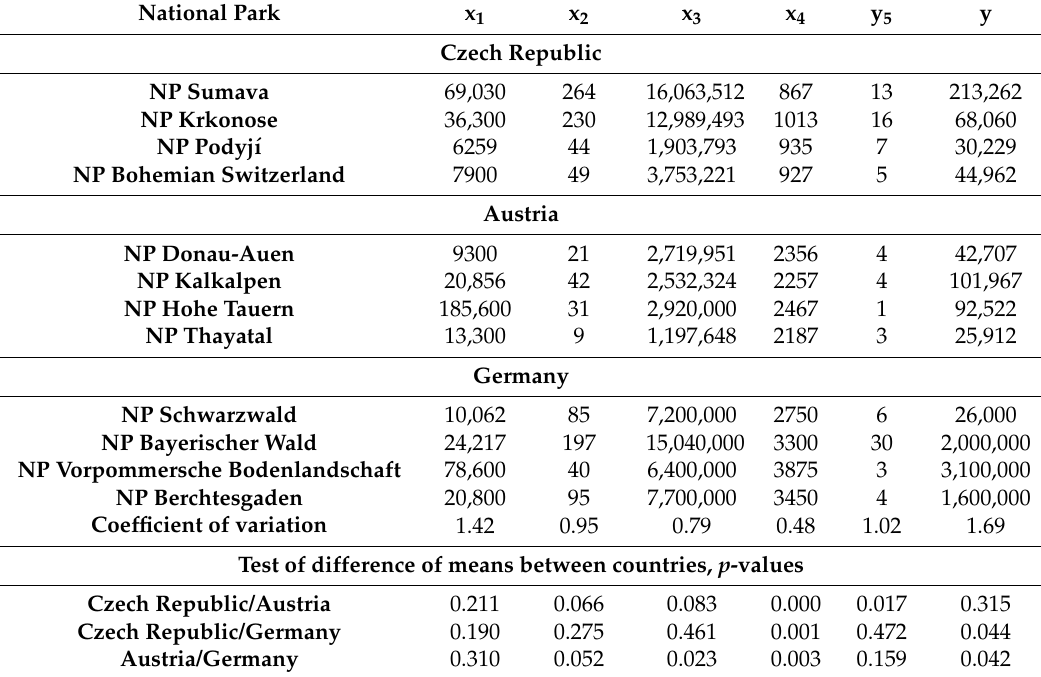
Table 1. Collected data of national parks in the Czech Republic, Austria and Germany.